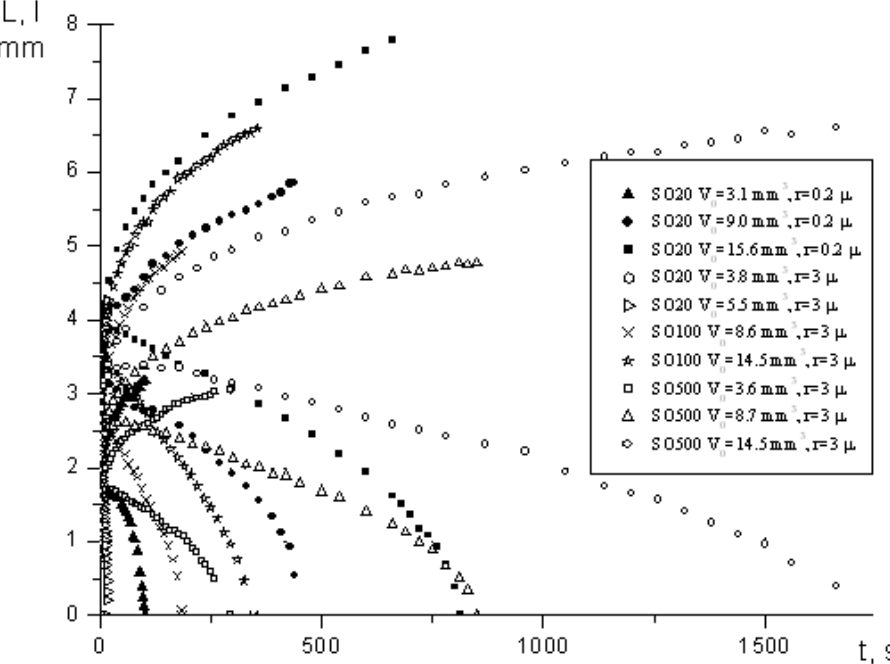
Figure 3. Measured dependencies of radii of the drop base ( L , mm) and radii of the wetted region inside the porous layer ( l , mm) on time ( t , s). All relevant values are given in [14].